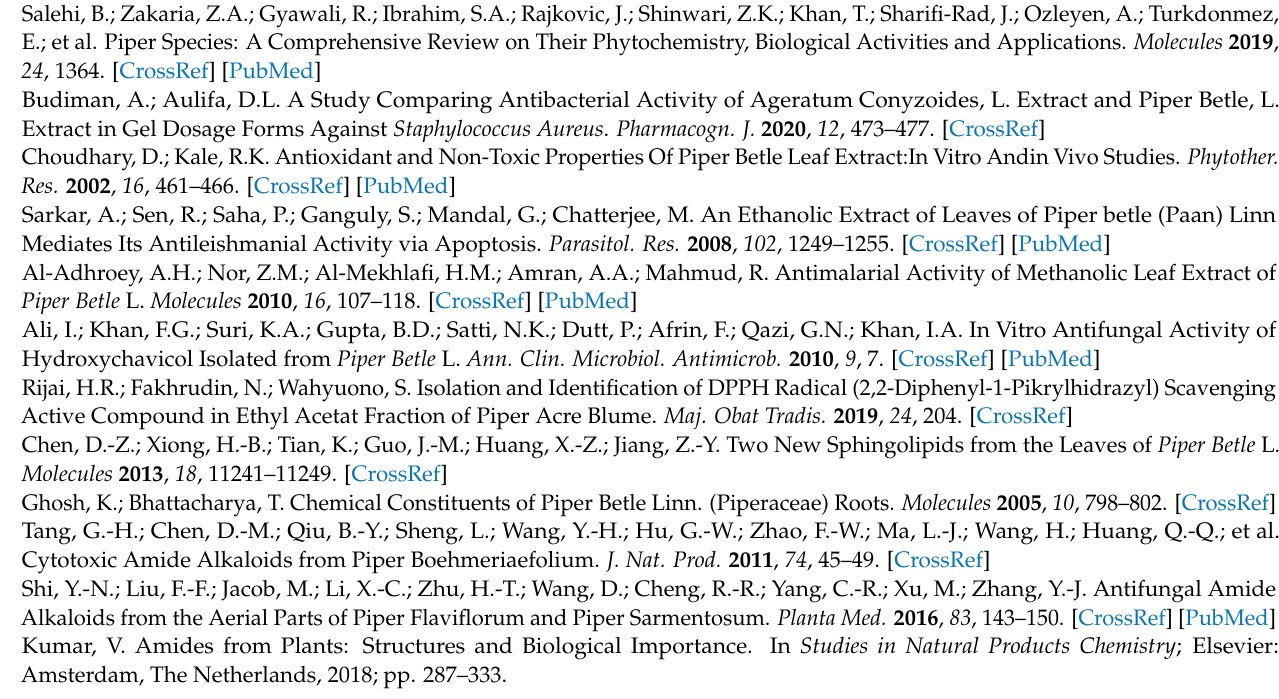
Figure S2: 13C-NMR Spectra of (1), Figure S3: DEPT-135 ◦ Spectrum of (1), Figure S4: HMQC Spectrum of (1), Figure S5: HMBC Spectrum of (1), Figure S6: 1H-1H-COSY Spectra of (1), Figure S7: TOF MS Spectra of (1), Figure S8: 1H-NMR Spectra of (2), Figure S9: 13C-NMR Spectrum of (2), Figure S10: DEPT-135 ◦ Spectrum of (2), Figure S11: HMQC Spectrum of (2), Figure S12: HMBC Spectrum of (2), Figure S13: 1H-1H-COSY Spectra of (2), Figure S14: TOF MS Spectra of